Question: Does the figure show an increasing or a decreasing trend?
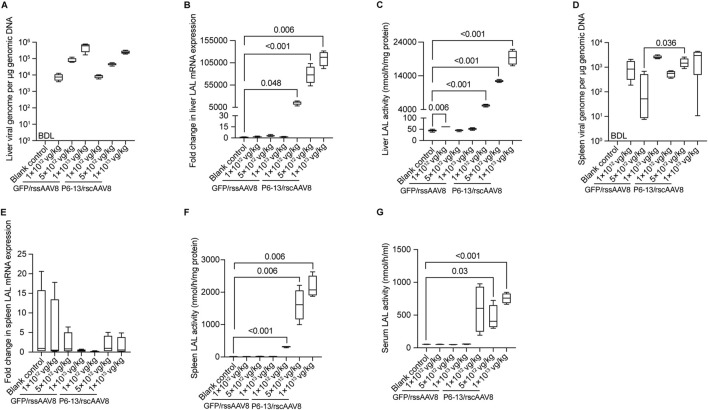
Answer: increasing